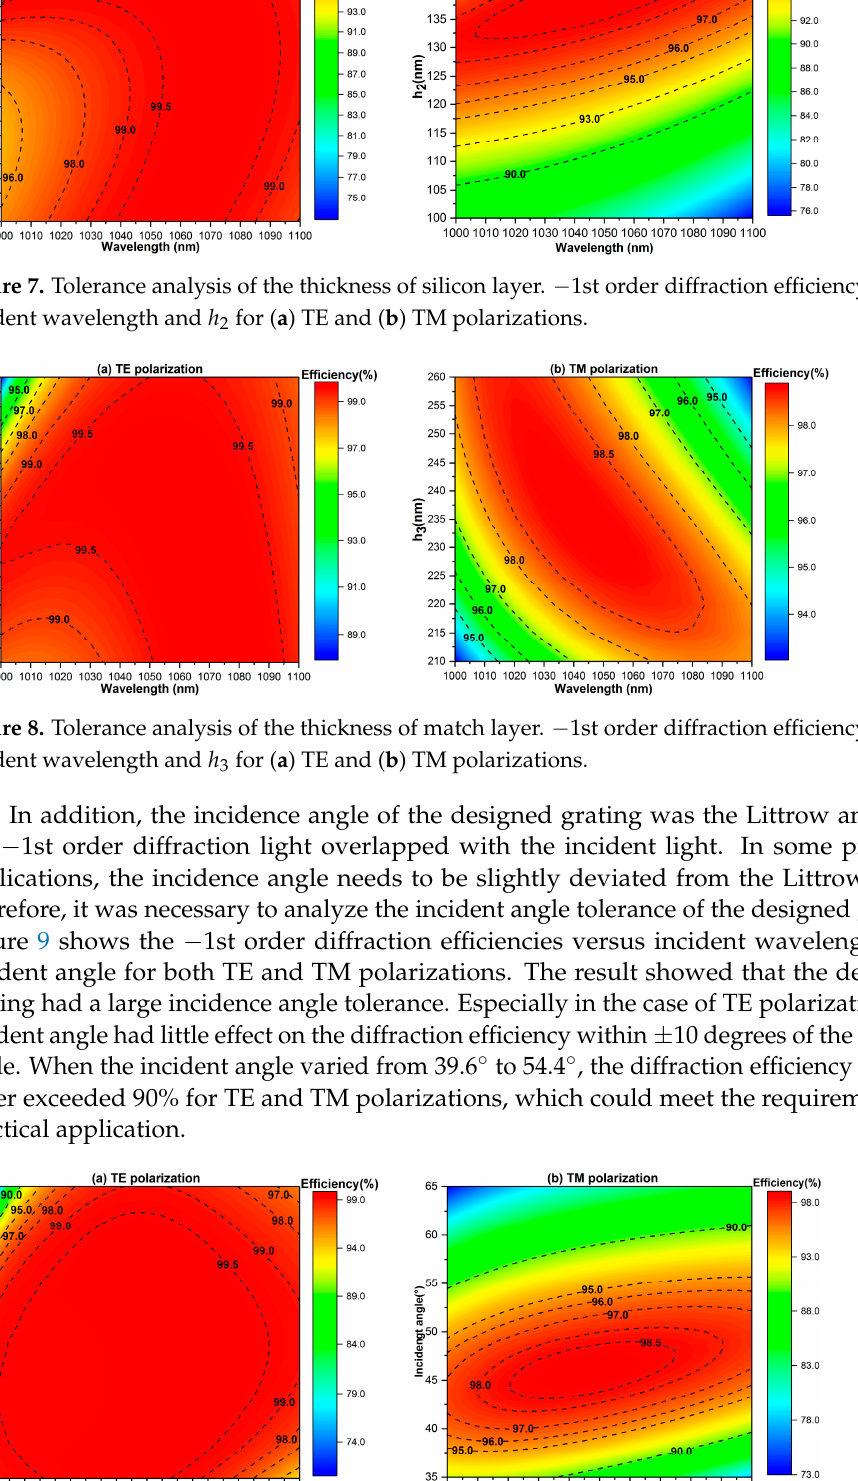
Figure 6. Tolerance analysis of the thickness of HfO 2 layer. − 1st order di ff raction e ffi ciency versus incident wavelength and ℎ (cid:2869) for ( a ) TE and ( b ) TM polarizations.